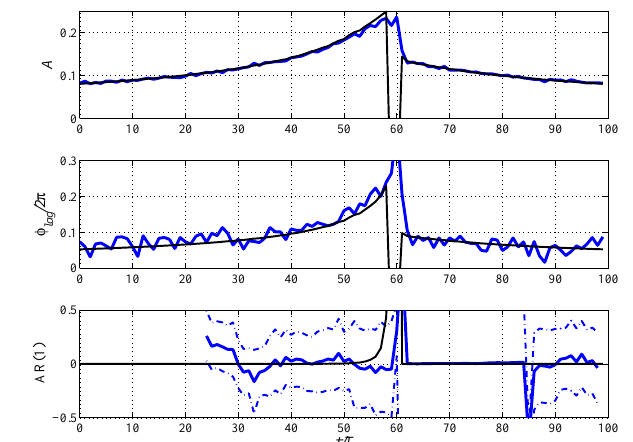
Figure 7. ωτ ∼ 4 π : The early warning indicators, response amplifi- cation (upper panel), A = D a τ √ , and phase lag (middle panel), 1 + ω 2 τ 2 φ lag = 1 arctan( ωτ ) calculated for the red time series in Fig. 5. 2 π 2 π In the lower panel, lag 1 autocorrelation of a sliding window of 25 points of the return map is plotted with standard errors (dashed lines) on the estimate. Black lines are theoretical curves of all the quantities. Phase lag and amplitude response have now asymptoted and are not useful quantities however the return map now becomes